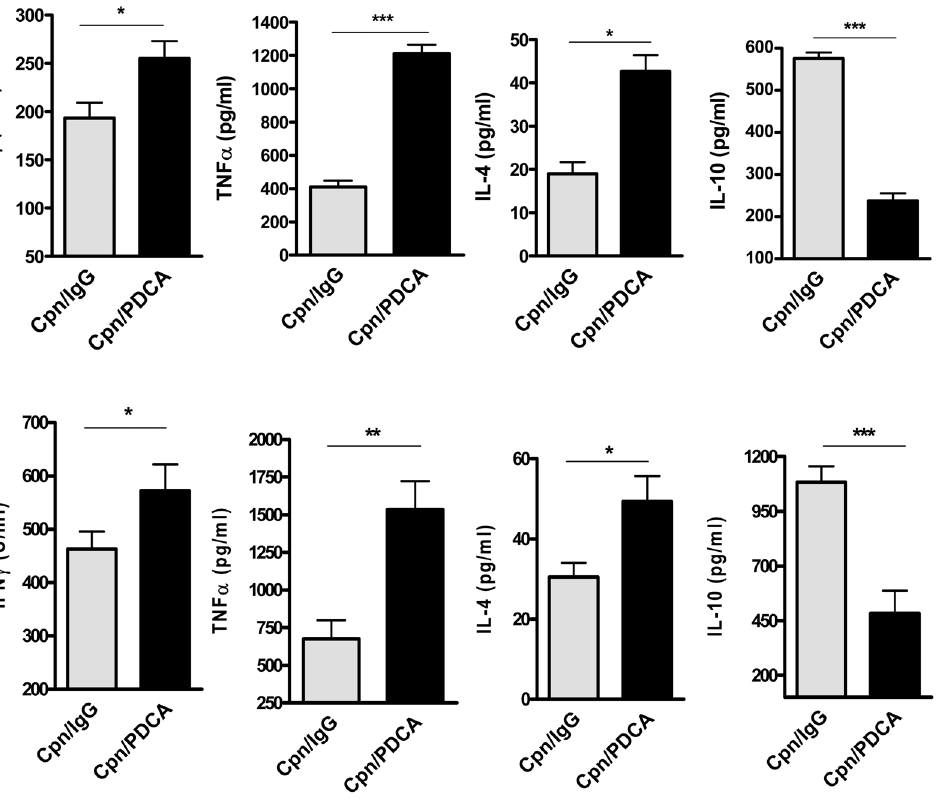
Figure 3. pDC deficiency invivo leads to altered cytokine responses. A , pDC depleted and the sham-treated mice (four mice/group), after Cpn infection were sacrificed 9 days postinfection and the lungs and draining (mediastinum) lymph nodes were collected. The draining lymph node (dLN) cells were cultured in the presence of SK-EB as described in Materials and Methods . Cytokine levels (IFN- c , TNF a , IL-4 and IL-10) in 72-h dLN cell culture supernatants ( A ) and lung homogenates ( B ) were measured by ELISA. Data are presented as the mean 6 SD of each group. Results of one of the three experiments with similar results are shown. *, p , 0.05, **, p , 0.01, and ***, p , 0.001; Student’s t test.